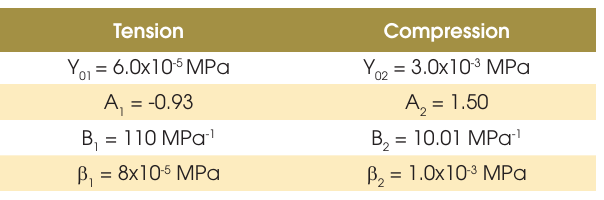
Table1 – Parameters for the proposed damage model – La Borderie’s RC